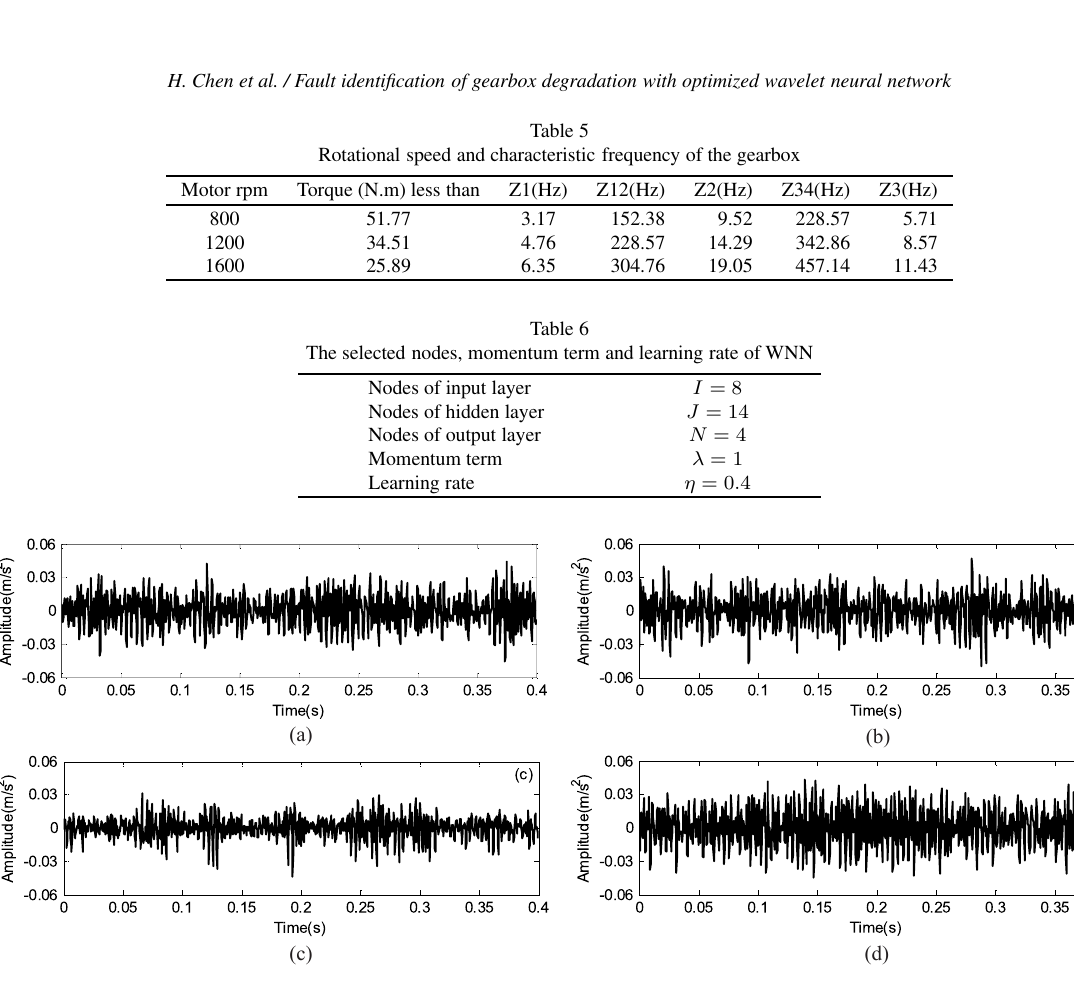
Fig. 7. The experimental vibration signal of the gearbox under four conditions, (a) F 1 , (b) F 2 , (c) F 3 and (d) F 4